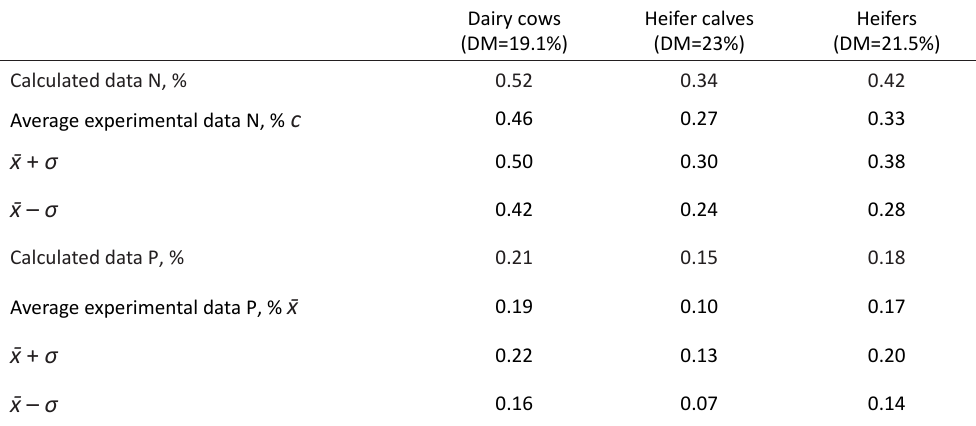
Table 5. Total nitrogen and phosphorus content in cattle manure at ex housing level (fresh manure) Dairy cows